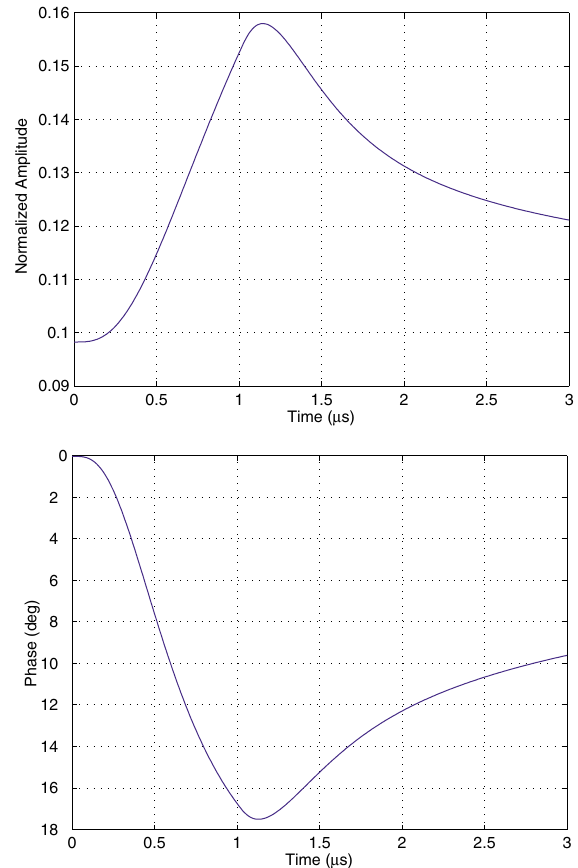
FIG. 13. (Color) Change in Q for a 10 MW, 1 (cid:3) s pulse.